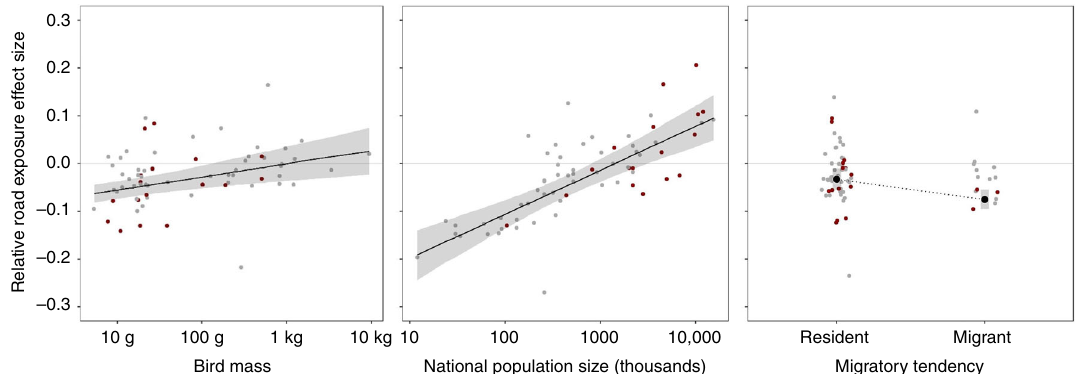
Fig. 6 Relationships between species characteristics and associations with road exposure. Black lines/points represent the relationships between relative effect size and each characteristic, from a model in which all fi ve characteristics were included. In all, 95% prediction intervals around each relationship are shown by the shaded grey bars. The grey and red points represent the sum of the predicted effect size and the model residual for each species — those in red are in the top 25% of model weight and thus had the strongest in fl uence on